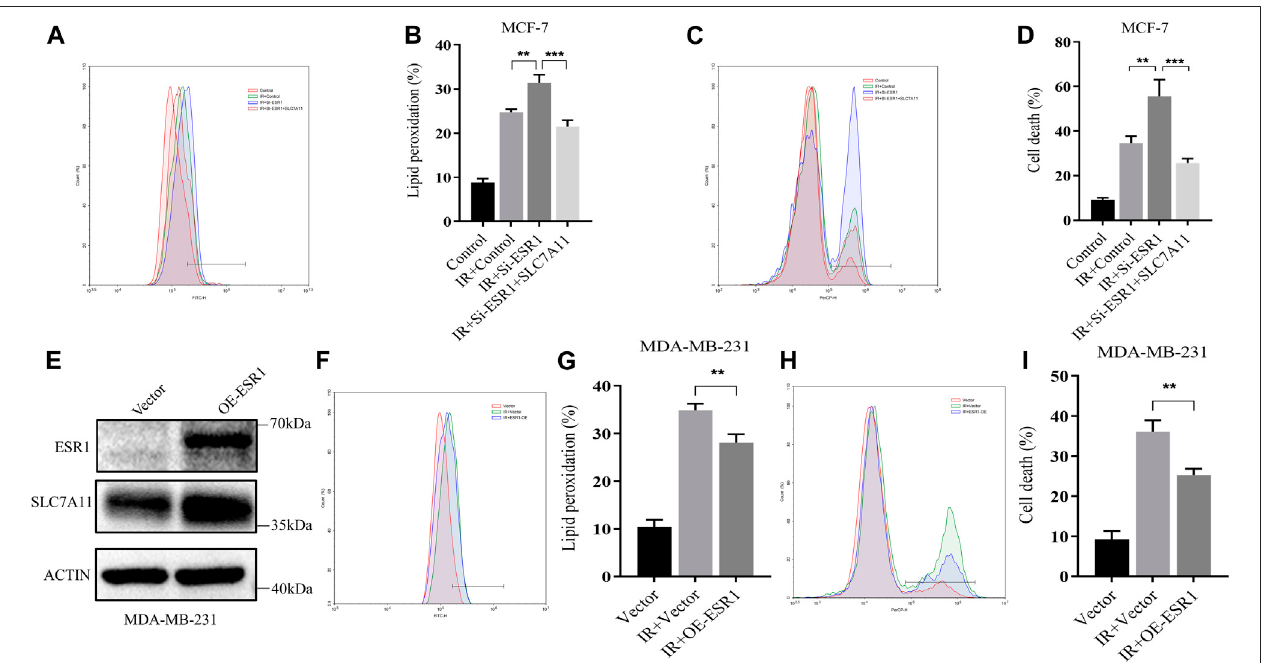
FIGURE 6 | Characterization of rescue cells and ESR1 overexpression. (A – D) MCF-7 cells were co-transfected with Si-ESR1 and pcDNA3.1-SLC7A11 for 48 h, then treated with IR (8 Gy). (E) Western blotting analysis of ESR1 overexpression in MDA-MB-231. (A – D, F – I) Lipid peroxidation and cell death were assessed by fl ow cytometry using C11-BODIPY and trypan blue, respectively. Shown is mean ± SD, n ≥ 3, ** p < 0.01; *** p < 0.001.